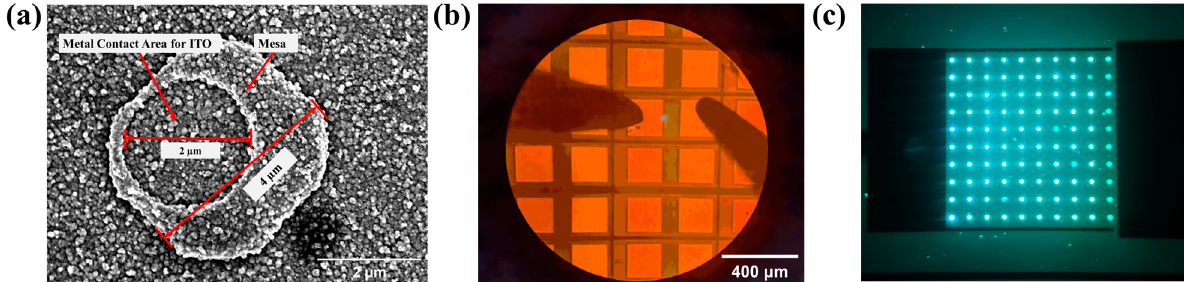
Figure 4. ( a ) SEM image of a 4 µm micro-LED; ( b ) the photo of a 4 µm micro-LED illuminated; ( c ) a photo of an array of 4 µm micro-LED illuminated.